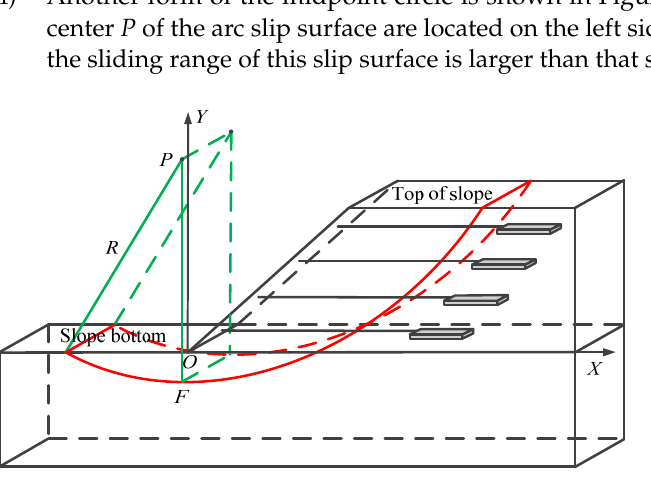
Figure 8. Schematic diagram of midpoint circle 1.